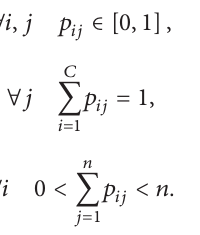
Figure 1: Distribution of the Three Gorges Reservoir and structure model of WSN water environment monitoring system.